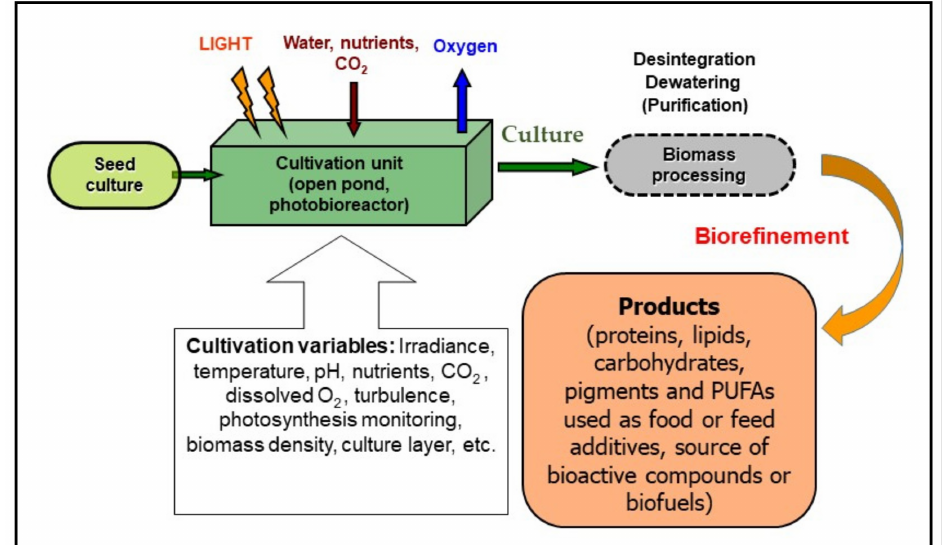
Figure 1. A schematic diagram of microalgae cultivation (and biomass processing) showing variables affecting the growth of microalgae. They are grown in a cultivation unit using an aqueous mineral medium and are exposed to light. However, a minimum biomass concentration corresponding to about 10 g per square meter (~0.2 g Chl m − 2 ) is recommended to avoid photo-stress. The operation variables—irradiance, pH, CO 2 supply, dissolved O 2 concentration, turbulence, photosynthetic activity, biomass density—have to be monitored and maintained to optimize the growth of the culture. During processing, the biomass is separated from the medium, disintegrated and dried for use as, e.g., food or feed additive, or as a source of bioactive compounds in pharmacology and cosmetics, or most recently for the production of biofuels, etc. (modified from Masoj í dek and Torzillo